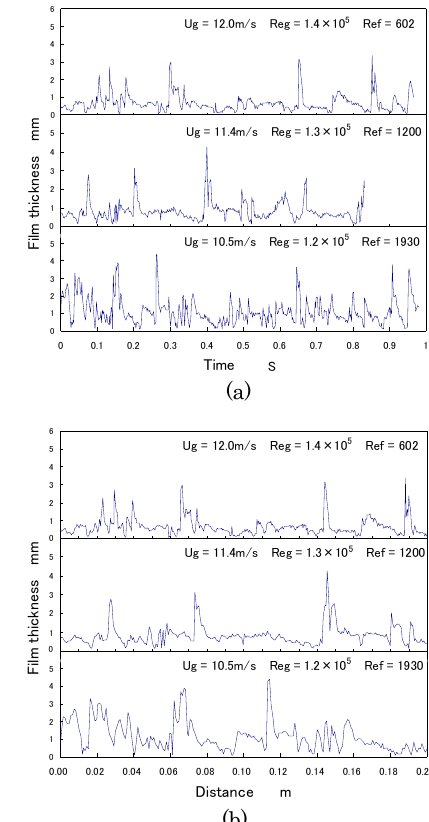
Fig. 2 Image of entrainment of a disturbance wave